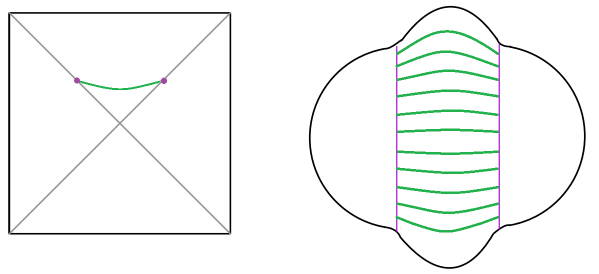
Figure 6 . A space-like slice containing the green surface between horizons. The right panel shows the bit-thread connecting the horizons. The bottleneck occurs at the horizons. The right panel of figure 6 shows a space-like slice through the geometry that includes the green curve. The bit-threads, emanating from the horizons, are laid out on the ( D − 1) surface as